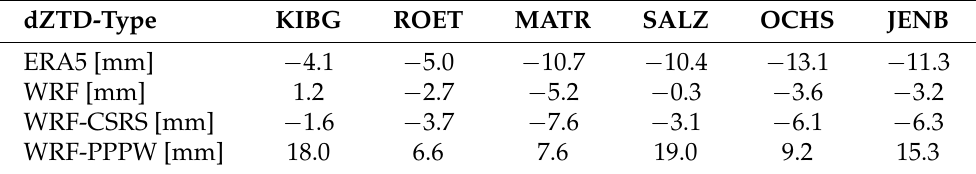
Table 10. Differences between ZTD estimates from EPOSA stations against WRF-ZTD without (WRF) and with assimilation of train-borne GNSS-ZTD (WRF-CSRS and WRF-PPPW) and ERA-ZTD calculated at the respective